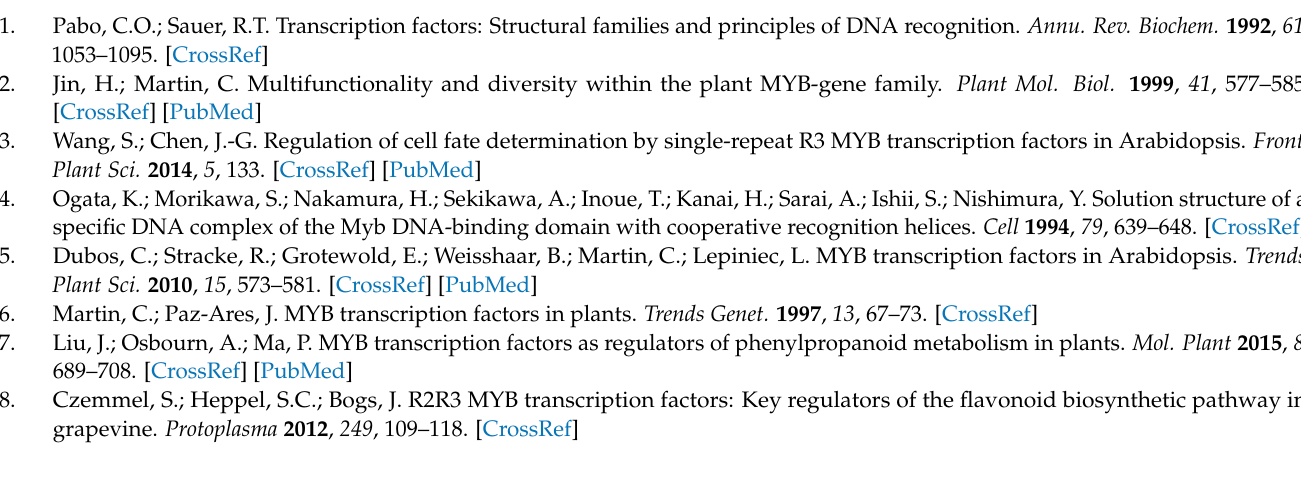
Table S2: The FPKM value of 217 MYB genes in different organs of woodland strawberry, Table S3: The RPKM value of 217 MYB genes in the ripening fruits of woodland strawberry, Table S4: The Table S5: The FPKM value of 217 MYB genes under heat and cold treatments of woodland strawberry seedlings, Table S6: The RPKM value of 217 MYB genes in the flowers, early-stage fruits, and ripening fruits of woodland strawberry, Table S7: The 15 motifs of 2R-MYB and 3R-MYB proteins from woodland strawberry, Table S8: The 15 motifs of 1R-MYB and 4R-MYB proteins from woodland strawberry, Table S9: The Sequences of 198 Arabidopsis MYB